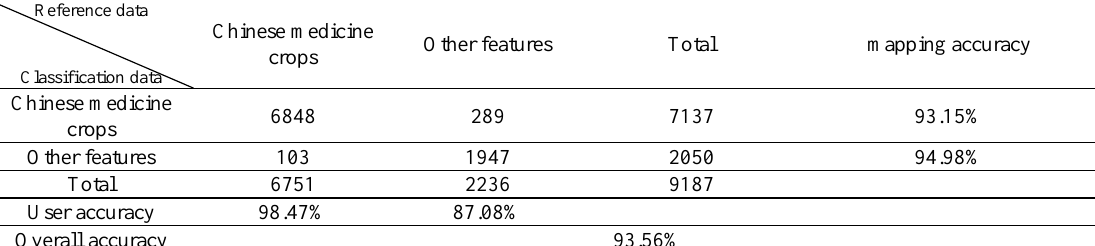
Table 6. Accuracy Evaluation of Chinese medicine